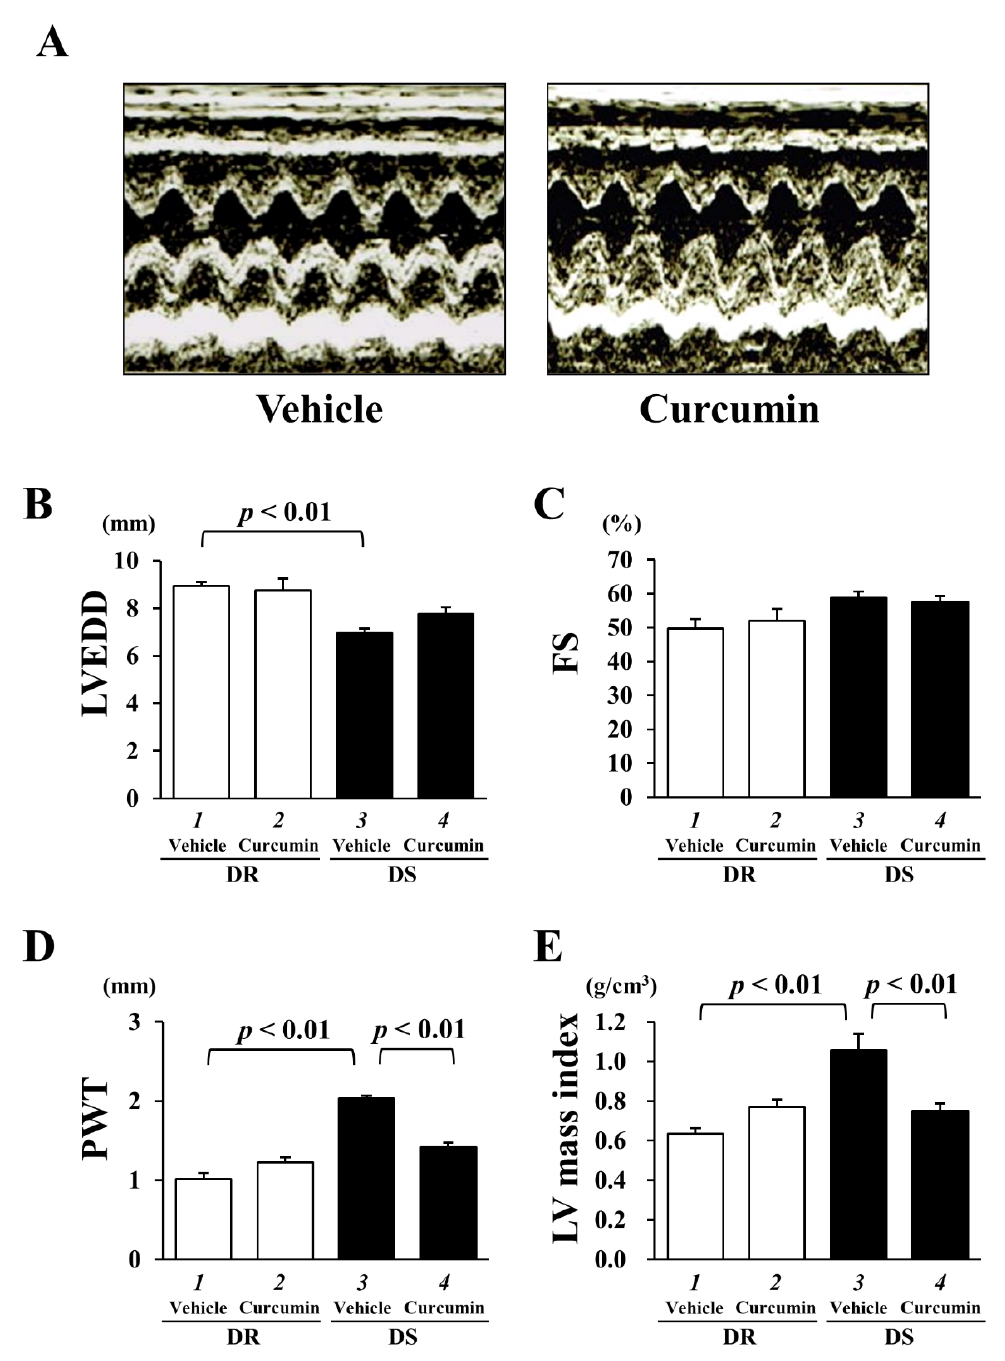
Figure 2. Curcumin treatment significantly reduced hypertension-induced posterior wall thickness (PWT) and left ventricle (LV) mass index without changing systolic function in DS rats. ( A ) Representative images of echocardiographic analysis in DS rats with vehicle or curcumin treatment. ( B ) LV end-diastolic dimension (LVEDD). ( C ) Fractional shortening (FS). ( D ) PWT. ( E ) LV mass index. Each value represents the mean ± SEM from 5 DR and 8 DS rats in each